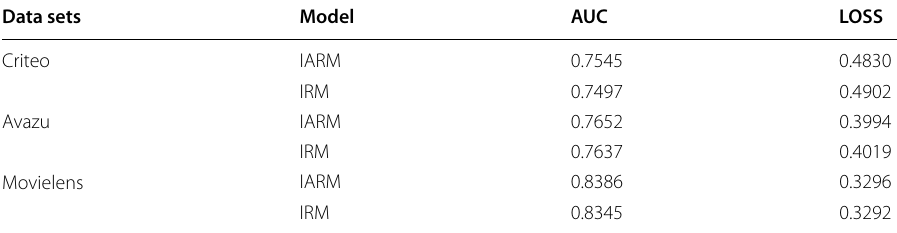
IRM is a model without the multi-head attention mechanism, while IARM is a full model